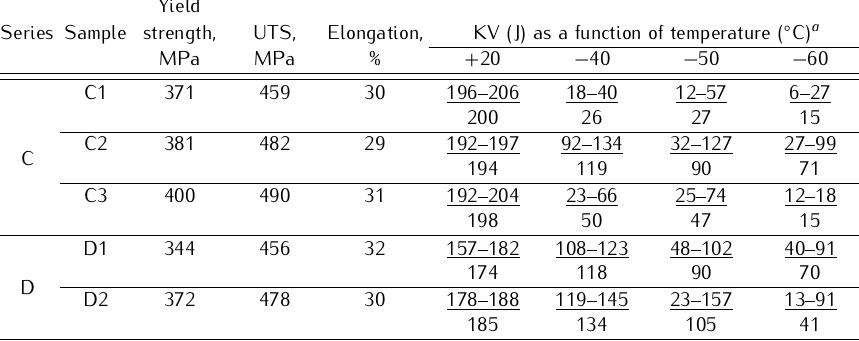
Table 5. Mechanical properties of weld deposits of series C and D electrodes made with S1L cores.